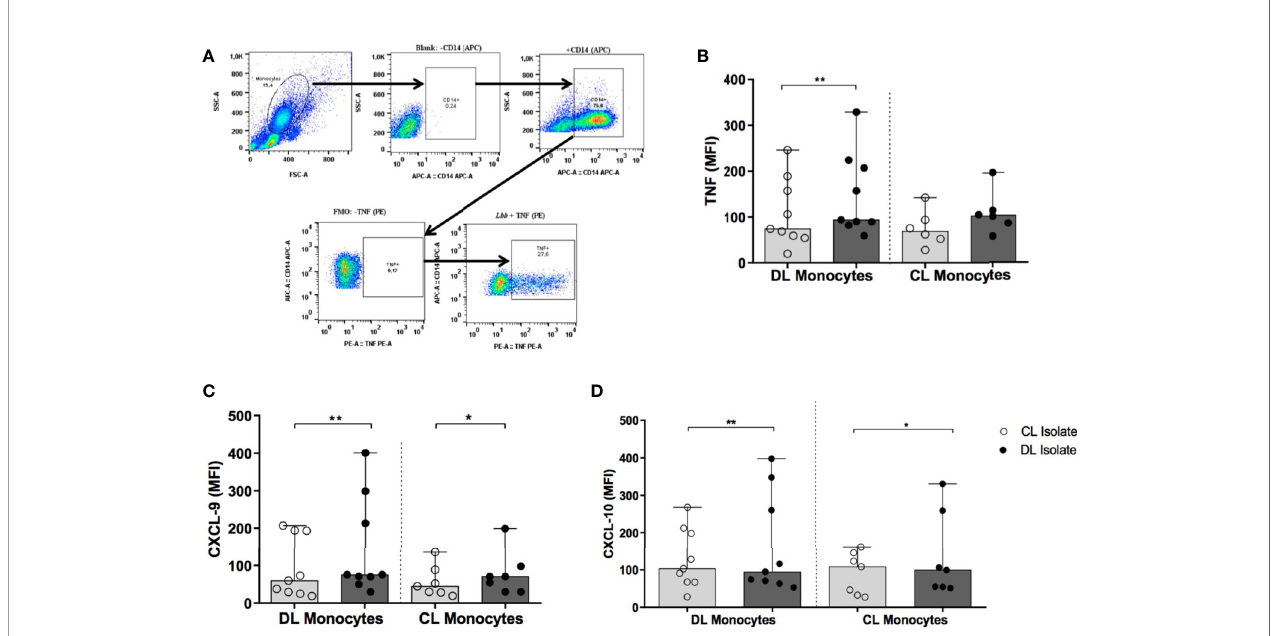
FIGURE 6 | Production of TNF, CXCL9 and CXCL10 by monocytes from patients with DL and CL following infection with different L. braziliensis isolates: PBMC from patients with DL (n=9) and CL (n=6) were infected with different isolates of L. braziliensis (5:1) for 2 h Cells were treated for 6 h with Stop Golgi, followed by surface staining with an anti-CD14 antibody for monocyte characterization. After permeative treatment, cells were marked with anti-TNF, anti-CXCL9 and anti- CXCL10 antibodies for fl ow cytometric analysis. (A) Representative graph illustrating intracellular production of TNF by fl ow cytometry. (B) TNF expression (C) CXCL9 expression. (D) CXCL10 expression. Results are presented as median fl uorescence intensity (MFI) values. All p values were obtained using Wilcoxon ’ s signed-rank testing, while comparisons between groups were made using the Mann- Whitney statistical test (*p < 0.05) (**p <